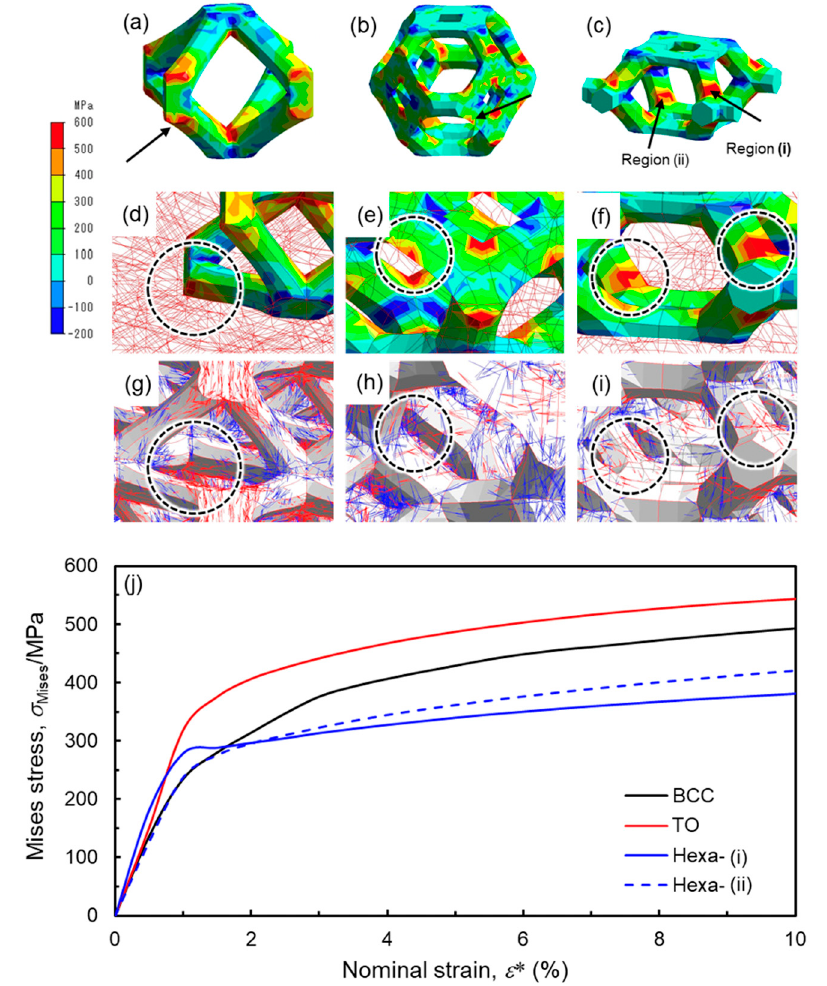
Figure 14. ( a – f ) Maximum principal stress distributions and ( g – i ) surface vectors of principal stresses in the ( a , d , g ) BCC, ( b , e , h ) TO and ( c , f , i ) Hexa lattice models. ( j ) Change in the Mises stress at the positions marked by arrows in ( a – c ).